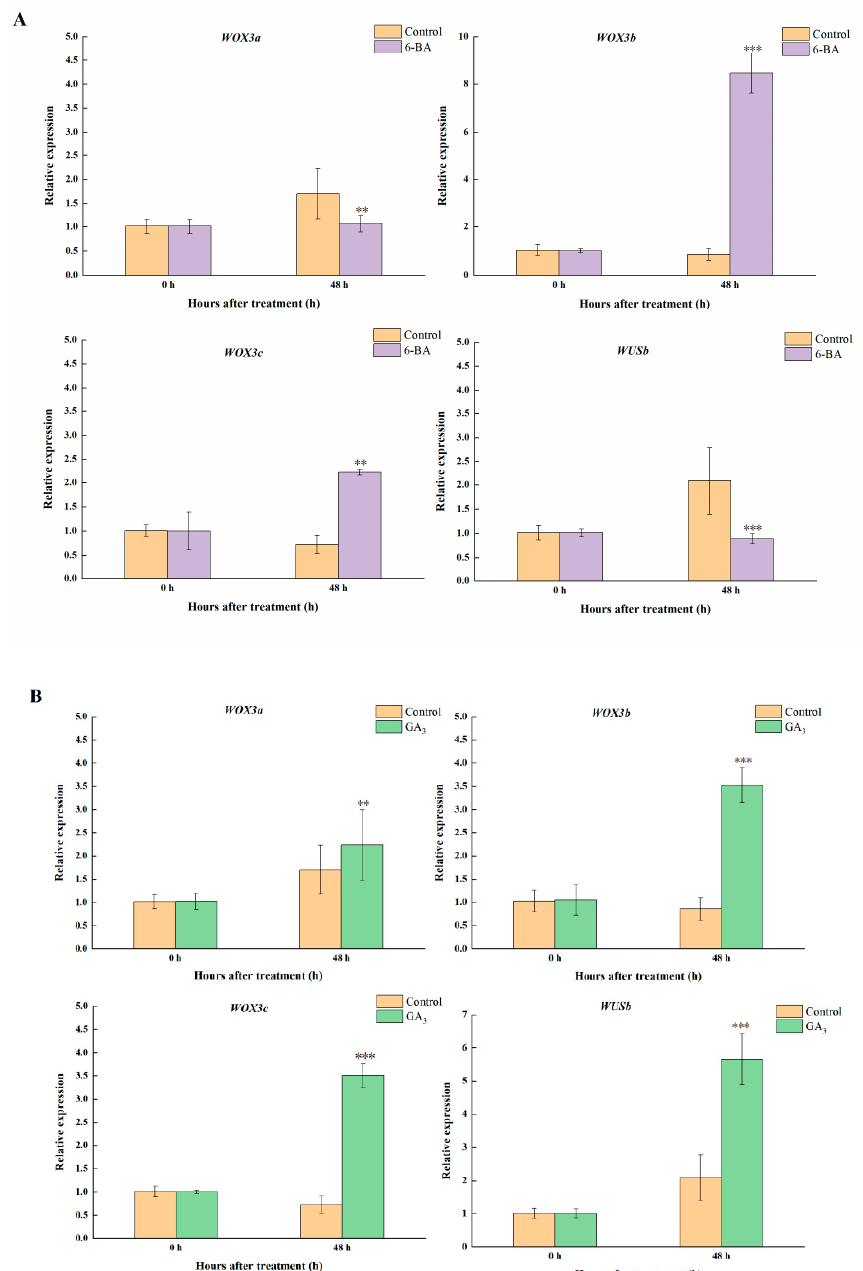
Figure 6. Expression changes of four FvWOX genes under 6-benzylaminopurine (6-BA) ( A ) and gibberellin (GA 3 ) ( B ) treatment. The crowns were taken as samples at 0 h and 48 h to detect the transcriptional level changes of the genes. Each value is the mean ± SD of three biological replicates. **, p < 0.01; ***, p <